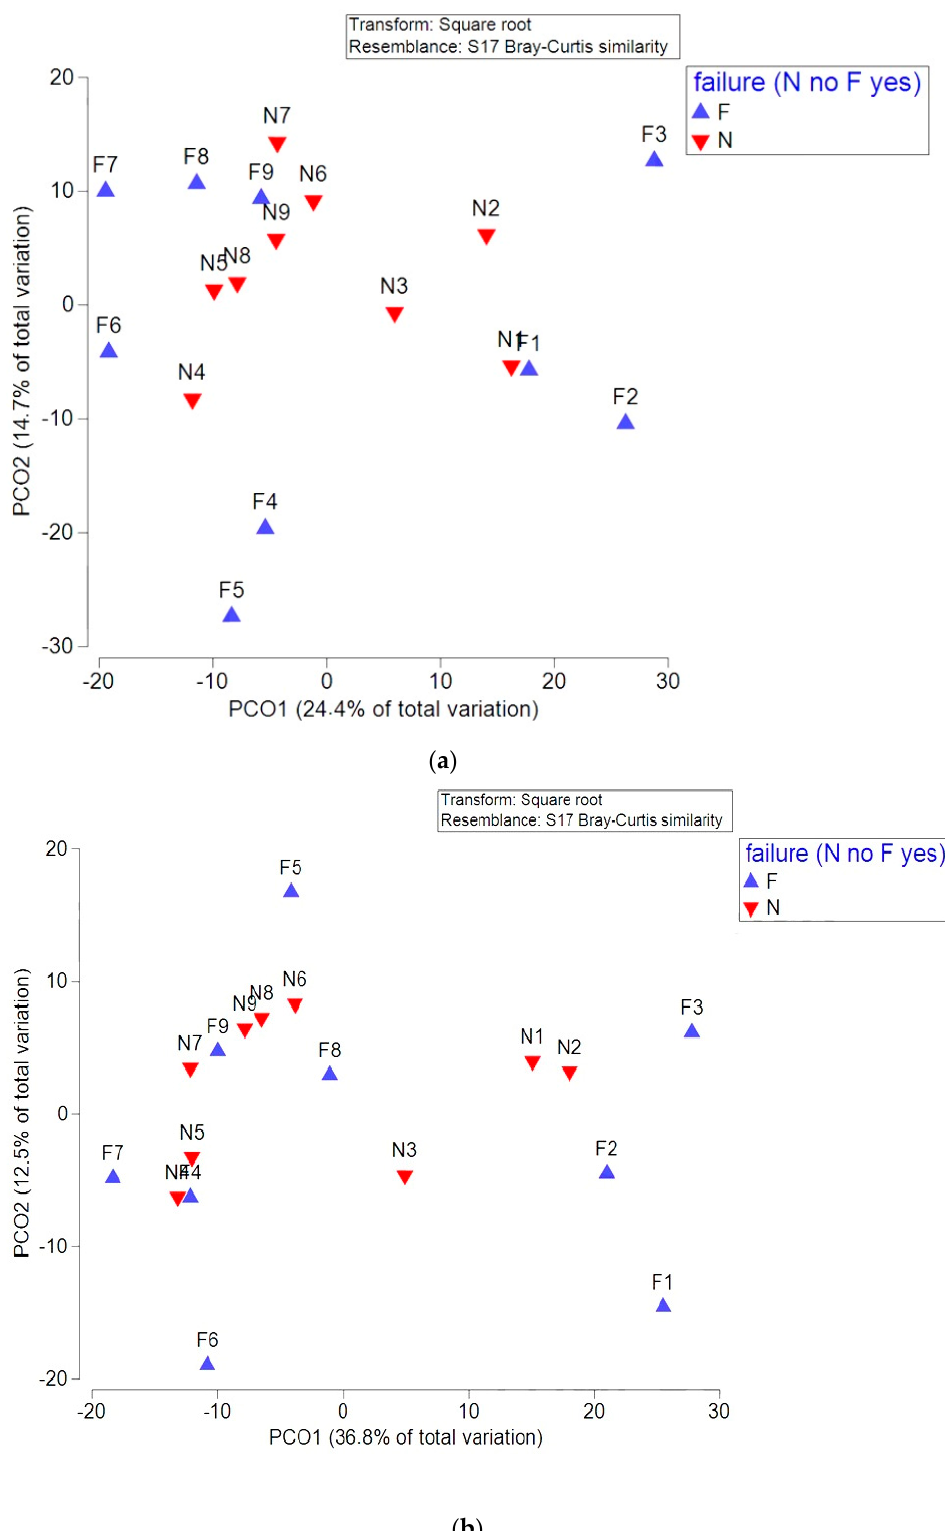
Figure 3. Principal coordinate ordination analysis (PCO) based on the OTU for ( a ) MspI -digestion, and ( b ) HhaI- -digestion showing two groups of patients (sustained remission (N) vs. non-sustained remission (F)) at different time points of EEN and post-EEN treatment. PCO was analysed